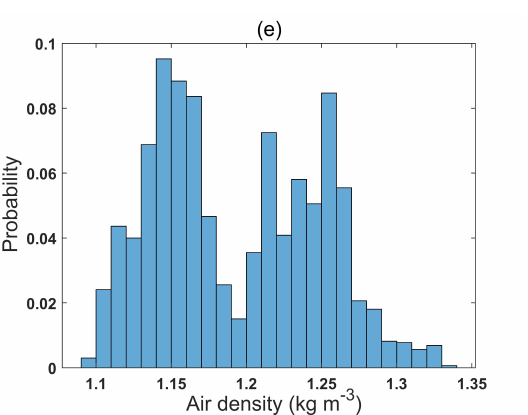
Figure 7. The observed distribution of meteorological variables based on ten-minute averaged data: ( a ) hub height wind speed (m · s − 1 ); ( b ) turbulence intensity ( TI ) at hub height; ( c ) shear exponent; ( d ) wind veer (degrees); and ( e ) air density at hub height (kg · m − 3